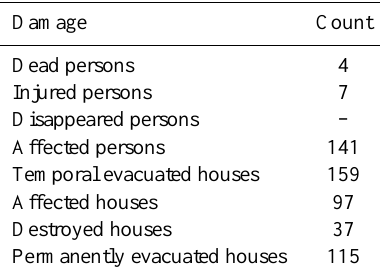
Table 5. Damages caused by all recorded landslides in the Iguan´a River Basin since